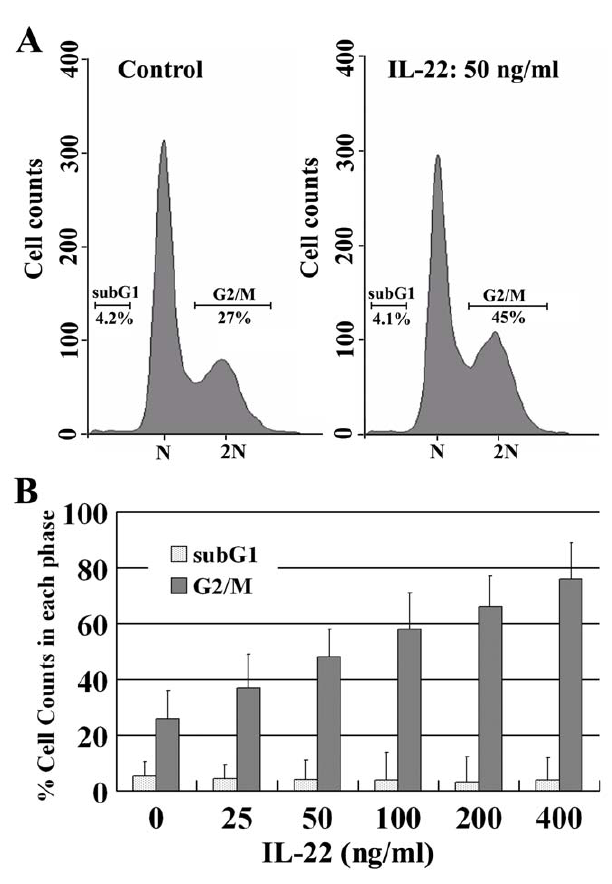
Figure 3. A498 cell cycle arrest in the G2/M phase after rhIL-22 exposure. A. After 50 ng/ml rhIL-22 exposure for 24 h, significantly more A498 cells accumulated in the G2/M phase of the cell cycle. B. With increasing doses of rhIL-22, more cells accumulated in the G2/M phase of the cell cycle. N=3.